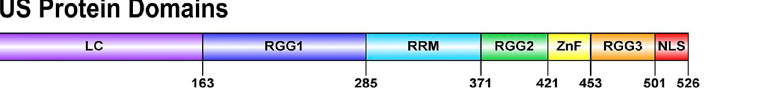
Fig 1. Graphic representation of the domains that compose the FUS protein. LC represents the low complexity, prion-like domain; RGG1 represents the first R-G-G pattern-rich domain; RRM represents the RNA-recognition motif; RGG2 represents the second R-G-G pattern-rich domain; ZnF represents the zinc-finger domain; RGG3 represents the third R-G-G pattern-rich domain, and NLS represents the nuclear localization signal.